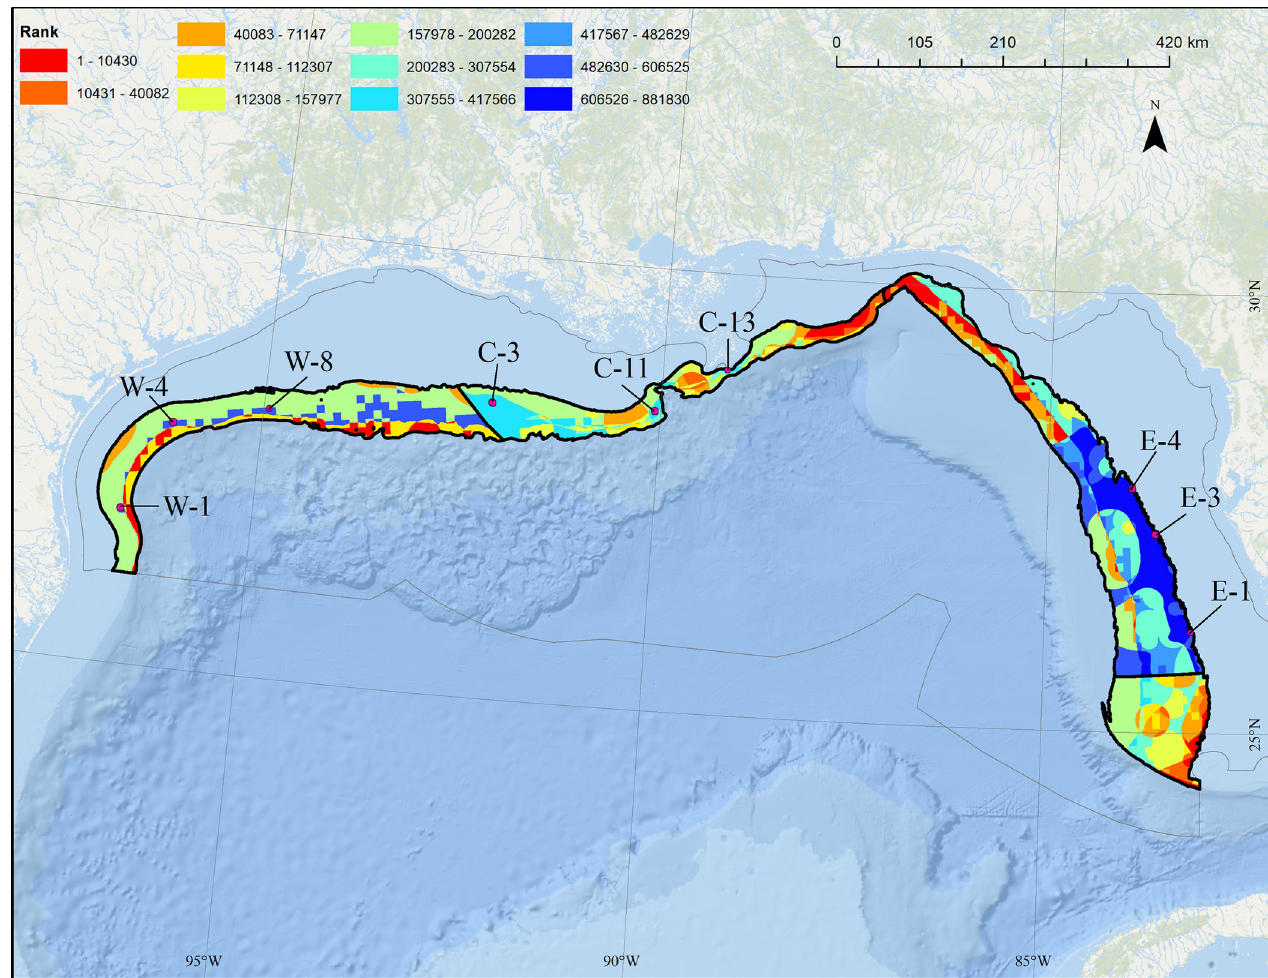
Fig 9. Combined ranked protected species data layer. Ranked scores using Product method relative to the nine final AOA options (green boxes; i.e., W-1, W- 4, W-8, etc.) resulting from the AOA analysis (see Fig 1) within each of the four aquaculture study sub-areas (black). Layer generated by combining Rice’s whale, five species of sea turtles, smalltooth sawfish, and giant manta ray layers using the Product method. Warmer colors denote areas of relatively higher concern with regards to species status, population size, and trajectory. Map developed in ESRI ArcGIS 10.8.1. Basemap from Esri Ocean Basemap and its partners, reprinted from ESRI under a CC BY license, with permission from ESRI, original copyright 2022. Projection: UTM NAD83 Zone